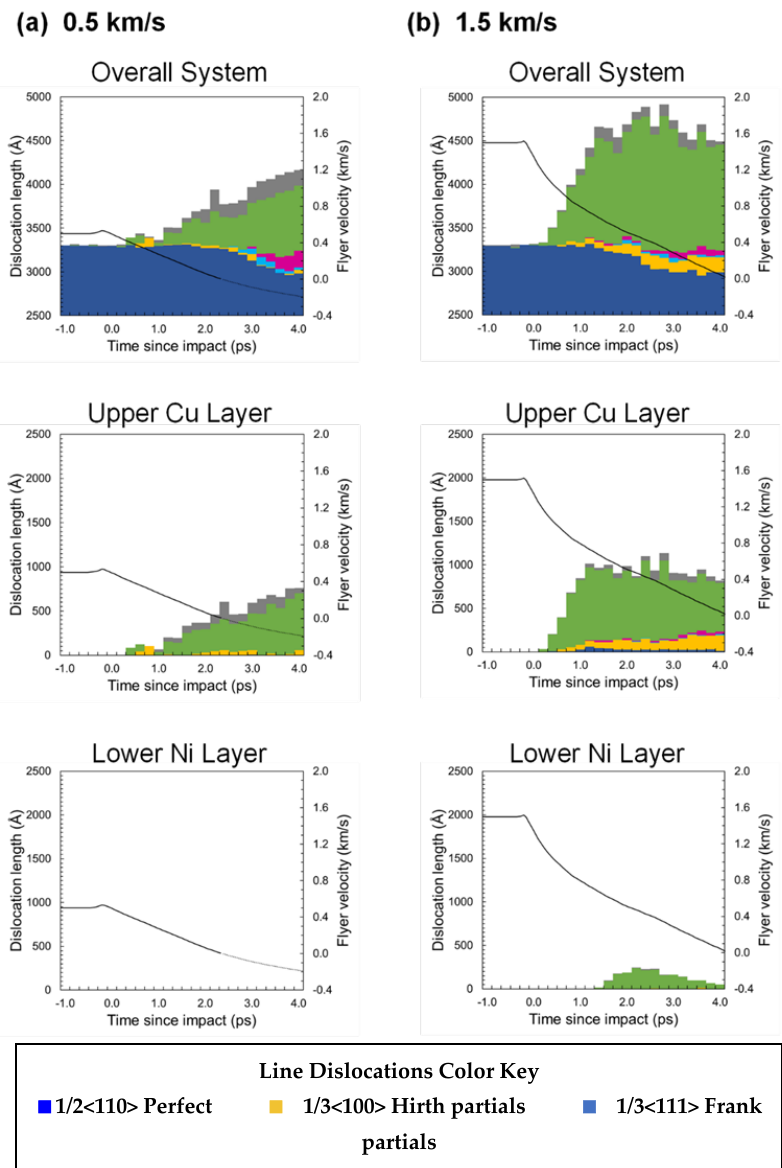
Figure 3. The relative lengths and types of line dislocations for initial impactor of ( a ) 0.5 km/s and ( b ) 1.5 km/s, plotted for the overall system (both layers including the interface) as well as for individual layers to show effect of interfacial interactions. The velocity of the impactor is also plotted such that the line is solid when the plate is moving downwards and dashed when moving upwards. As an alternative way to quantify and visualize dislocation behavior in the system, the positions of any atoms with a non-FCC local structure were converted to radial coor- dinates and then plotted (Figure 4) to visualize position and local defect density, where defect refers to atoms not adhering to the bulk FCC structure. The defect density was cal- culated by normalizing the number of defect atoms by the volume of annular cylindrical bins of width 0.5 nm and height 0.5 nm. As shown in Figure 4, the defect density consist- ently agrees with phenomena observed in the previously discussed DXA analysis. For